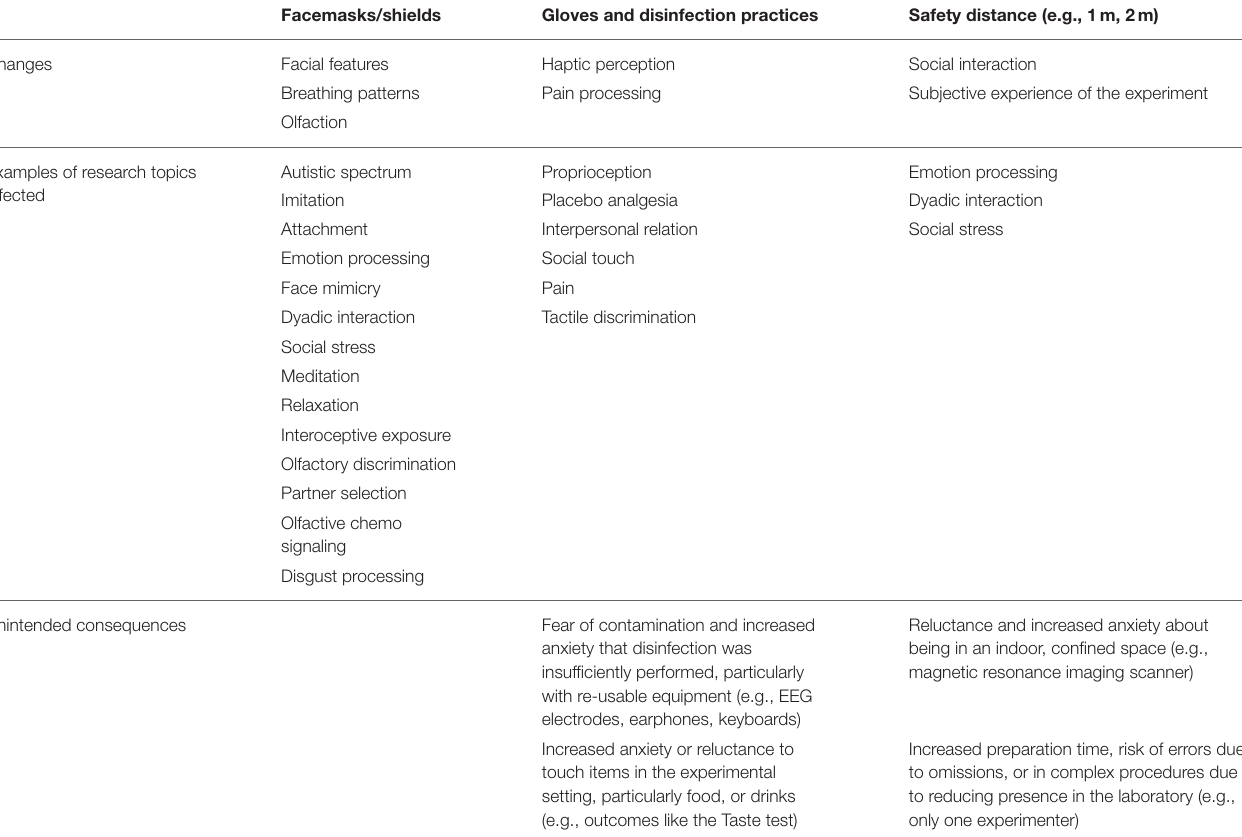
TABLE 1 | Possible consequences of non-pharmacological interventions for COVID-19 on human behavior